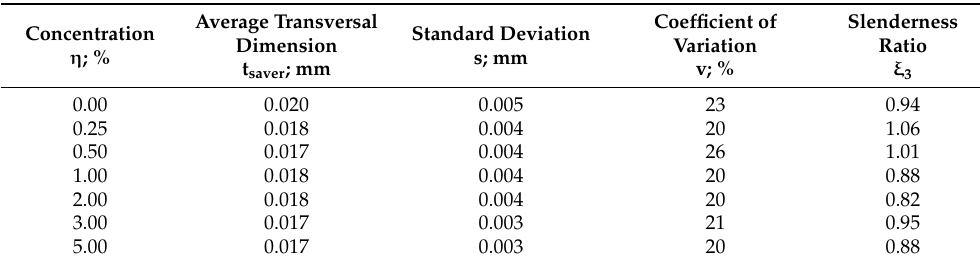
Table 9. Characteristics of the struts’ transversal